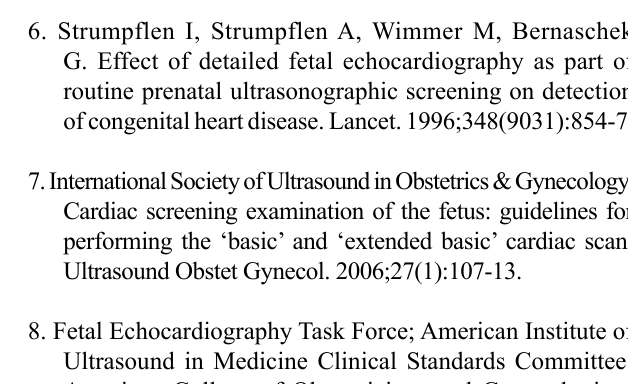
Fig. 2 - STIC-HDlive rendering showing the reconstruction of fetal heart and its vascular